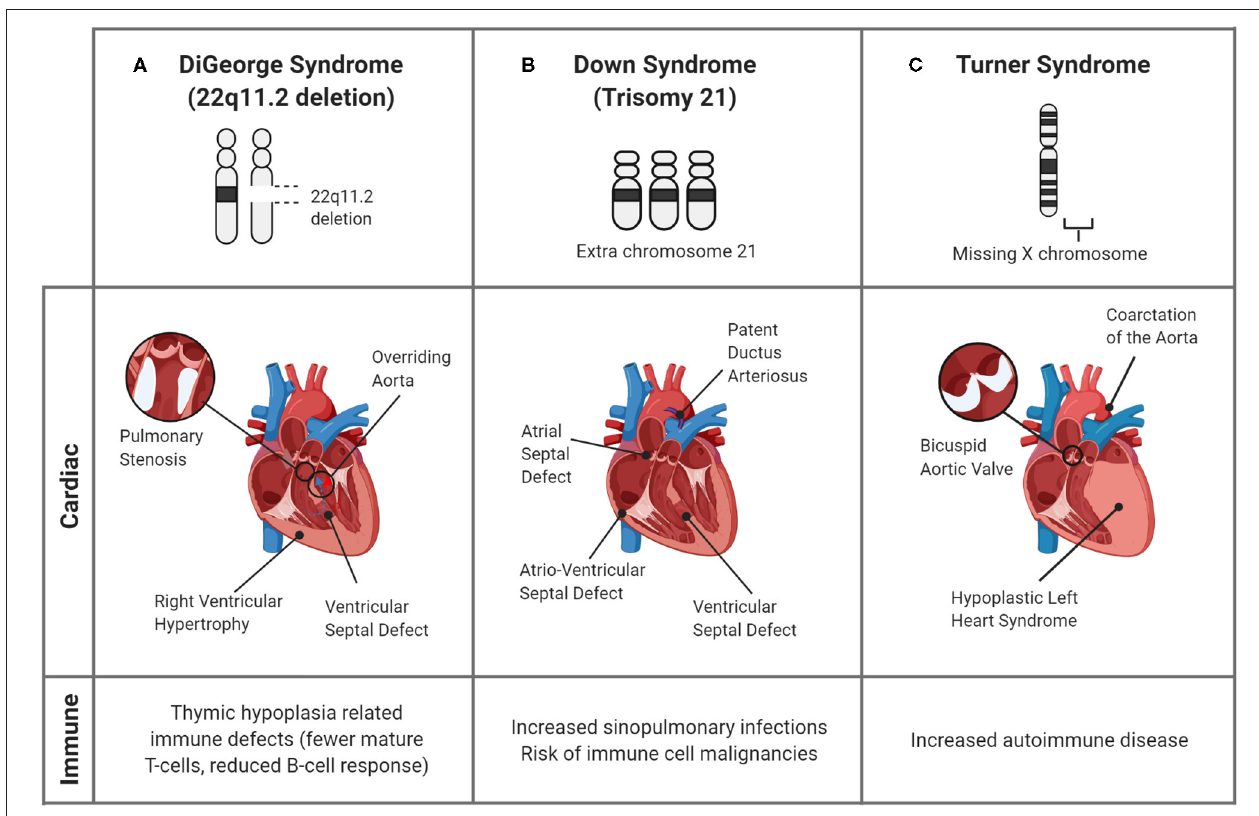
FIGURE 3 | Genetic syndromes associated with CHDs and altered immune responses. Though many genetic syndromes are associated with both immune deficiencies and CHDs, they are not linked directly. (A) In DiGeorge Syndrome, the abnormal development of the pharyngeal arches, the precursor structure for both the heart and thymus, leads to mature T-cell deficiency and cardiac defects. (B) Down Syndrome is commonly associated with cardiac septal defects and an increased propensity for infections in childhood. Though the associations are unclear, the alterations in immune response are evidenced by the greater prevalence of immune cell malignancies. (C) In Turner Syndrome, children can have CHDs, including bicuspid aortic valve and aortic damage, as well as immune complications, such as autoimmune disease. A connection between the cardiac and immune systems is seen in the inflammatory complications of the bicuspid valves,